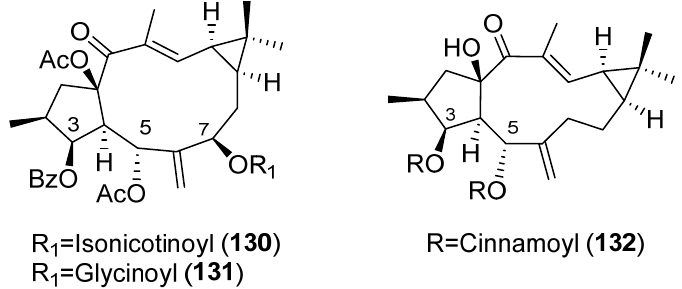
Figure 22. Structure of compounds 130 – 132 .